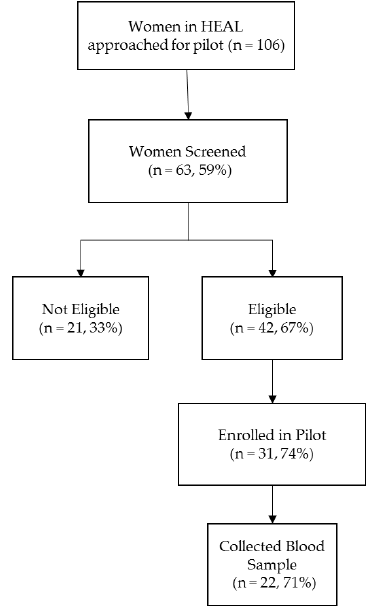
Figure 1. Flow chart of study recruitment.